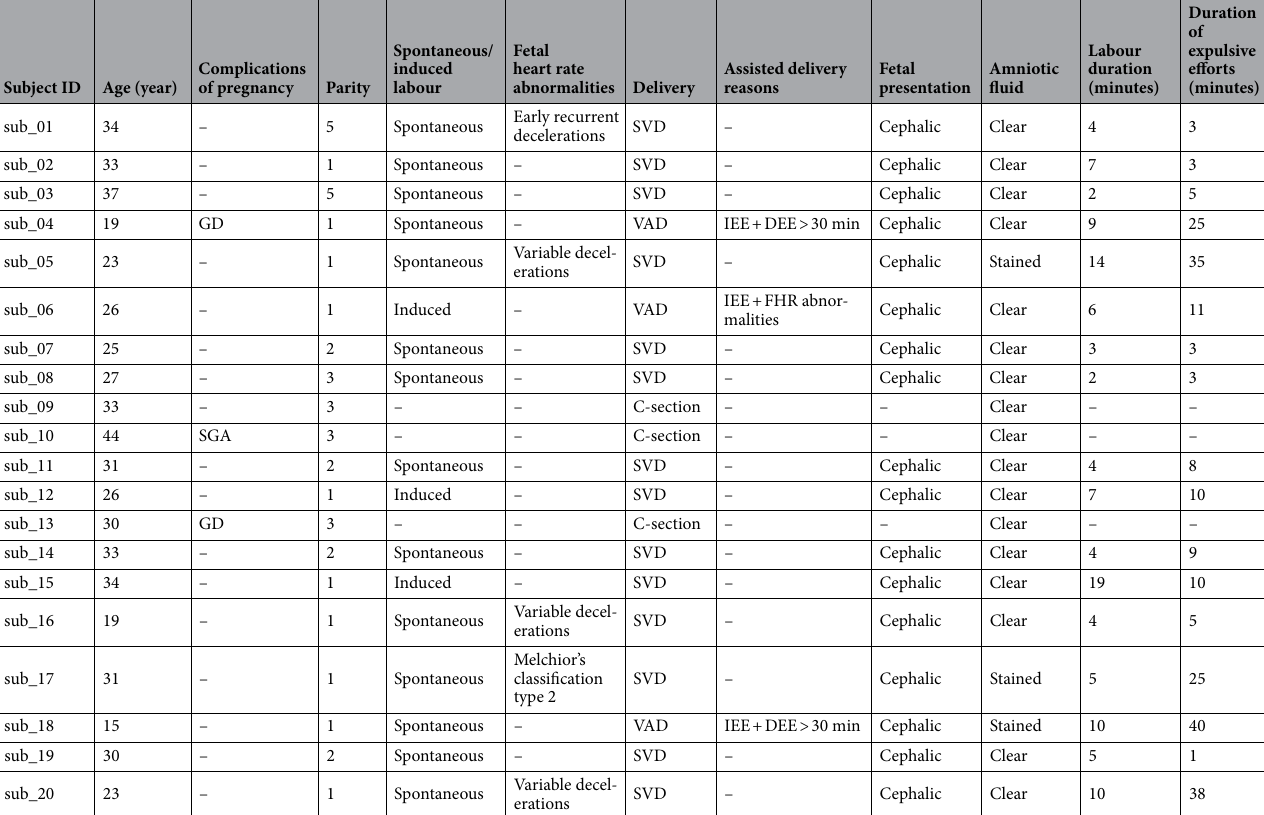
Table 2. Clinical features of the tested infant’s mothers. GD gestational diabete, SGA small for gestational age, SVD spontaneous vaginal delivery, VAD vacuum-assisted delivery, IEE inadequate expulsive efforts, DEE duration of expulsive